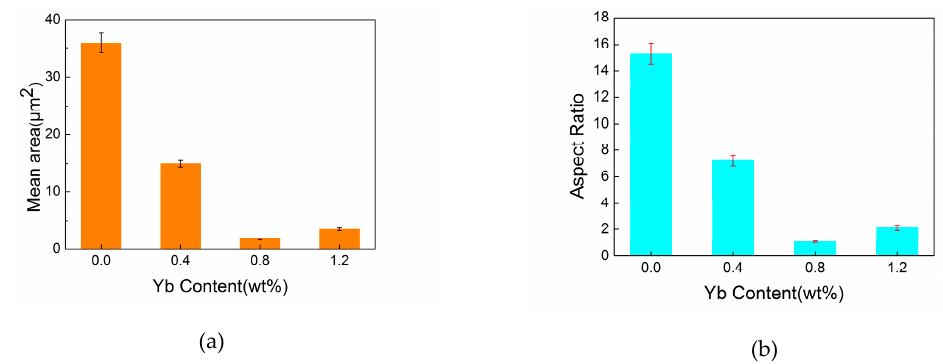
Figure 4. Mean area and aspect ratio of eutectic Si phases with different Yb additions: ( a ) mean area; ( b ) aspect ratio.